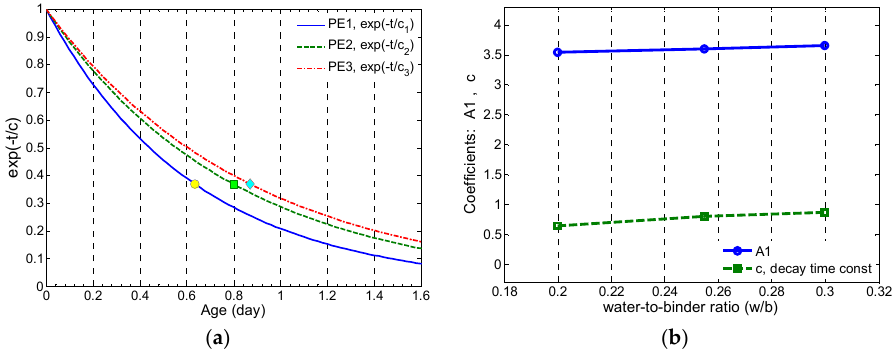
Figure 8. ( a ) Comparison of time constants for step responses; ( b ) Regression coefficients A 1 and c (time constant) versus w / b .